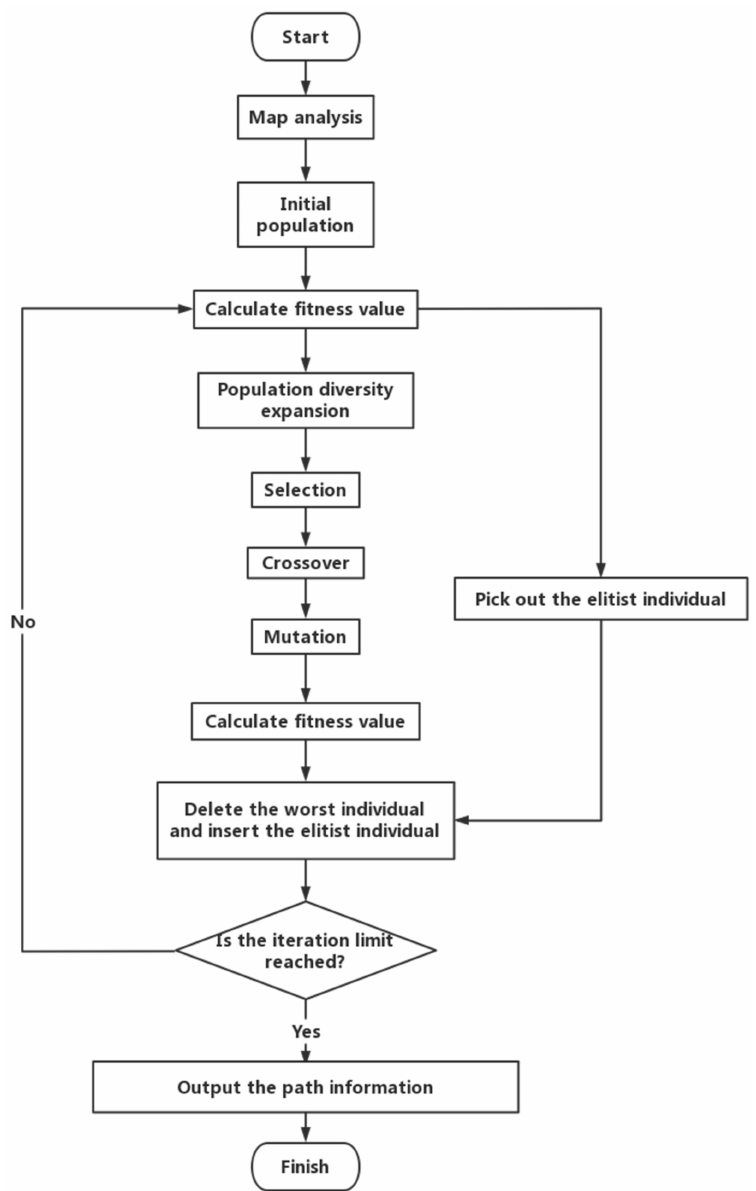
Figure 9. Flowchart of